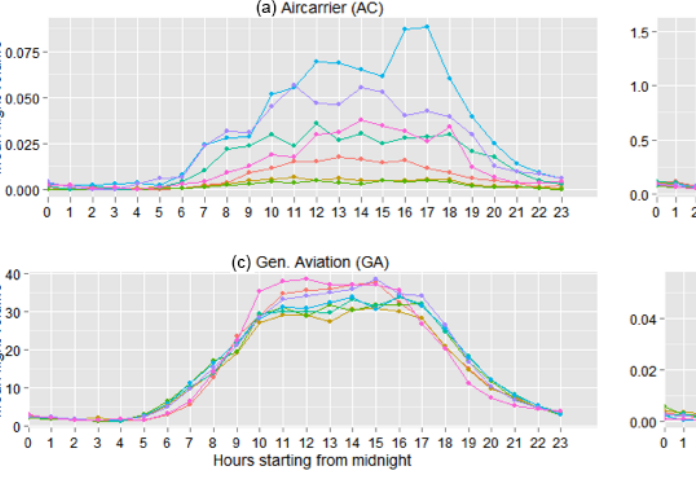
Figure 6. Same as Fig. 4 but for the Van Nuys (VNY)